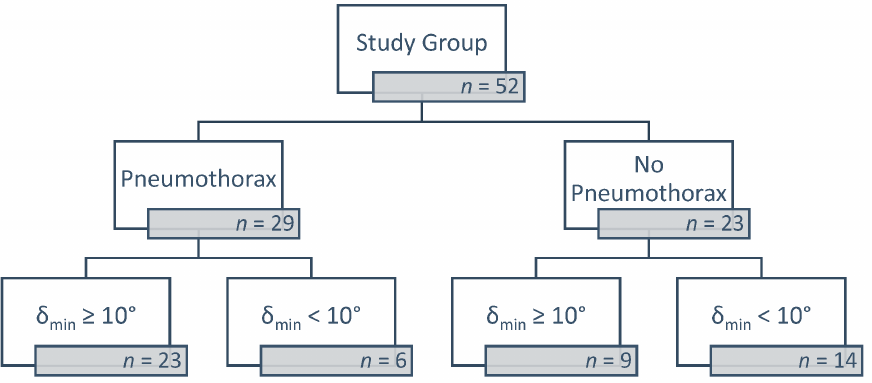
Figure 1. Flow chart of the patient classification process.